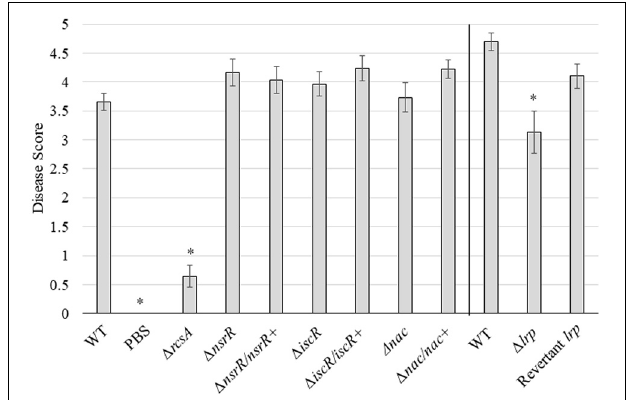
FIGURE 4 | Competition assay for P. stewartii mutant strains lacking select transcription regulators. Deletion (Nal R ) and complementation (Nal R /Cm R ) or WT (Nal R /Tet R ) sets of nsrR , iscR , lrp , and nac mutants and the ompC control were co-inoculated into the corn seedlings at a 1:1 ratio. The RCI for each set was calculated as the ratio of deletion to complementation or marked WT strains extracted 5 days postinoculation over the ratio of deletion to complementation strains in the inoculum. N ≥ 6 per inoculum with the bar representing the average value. A Wilcox pairwise statistical comparison was done via R programming. The RCI values for the experiment performed with the DSJ_21690 strain (see Supplementary Figure 6 ) with an average value closest to one were used as the baseline for comparison to the other strains. n.s. indicates not significant ( p > 0.05), and ∗∗∗ indicates significant differences ( p <